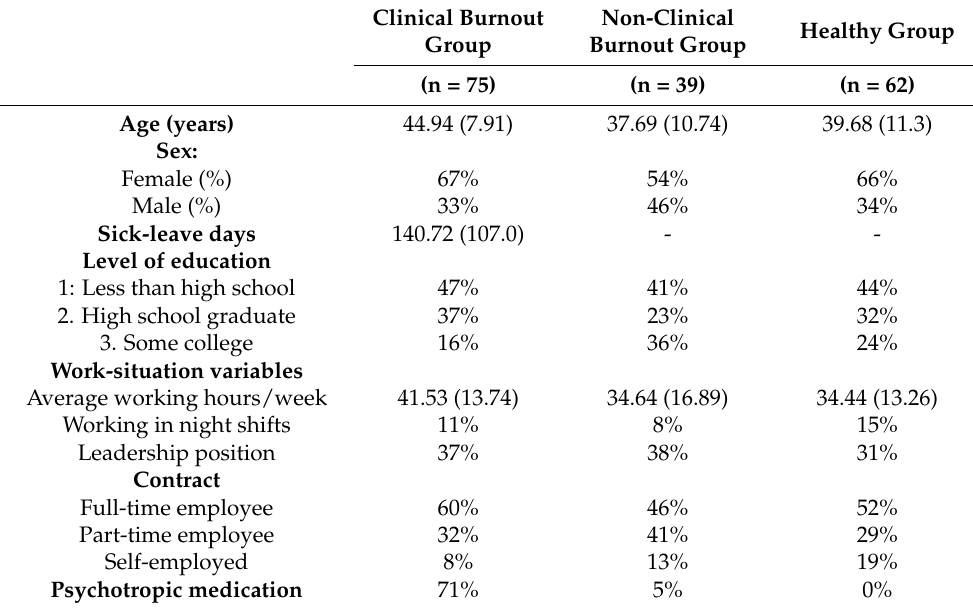
Table 1. Sociodemographic